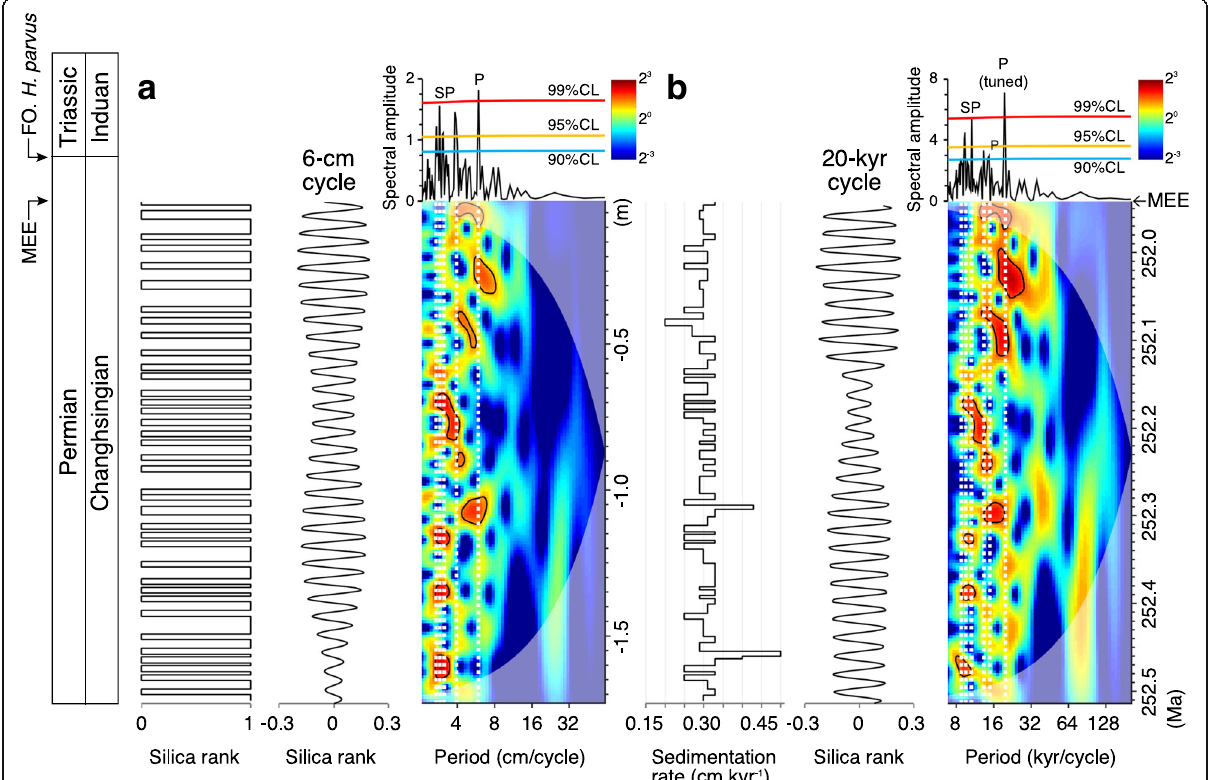
Fig. 6 Cyclostratigraphy and floating astronomical time scale (ATS) of the Waidani section. a Silica rank and frequency – amplitude modulations of the Upper Permian (Changhsingian) bedded chert sequence. The average sedimentation rate for the Changhsingian bedded chert is ~ 0.3 cm kyr − 1 , so the extracted 6 cm cycle was converted to a long precession cycle (~ 20 kyr) for orbital tuning (Yao et al. 2015). b Variations in sedimentation rate for each bed, calculated from the Changhsingian ATS and frequency – amplitude modulations of orbital-tuned silica rank. Red, orange, and blue lines in the REDFIT spectra delineate 99%, 95%, and 90% confidence levels (CL) against red-noise background from a first-order autoregressive process, respectively (Schulz and Mudelsee 2002). P and SP at the spectral peaks represent precession and semi-precession (Berger et al. 2006; Soda et al. 2015), respectively. Black contours and shaded regions in the wavelet spectra indicate 95% CL against the red noise and cone of influence due to zero padding, respectively (Torrence and Compo